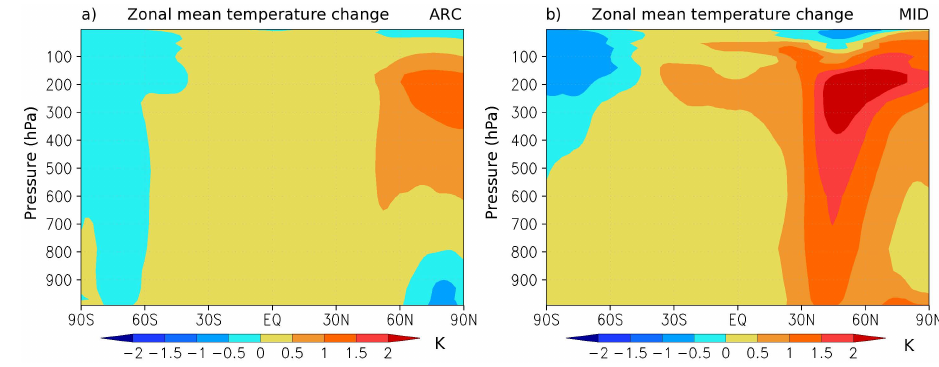
Fig. 5. Zonal annual mean temperature change (in K) for (a) the ARC-CONTROL and (b) the MID-CONTROL.